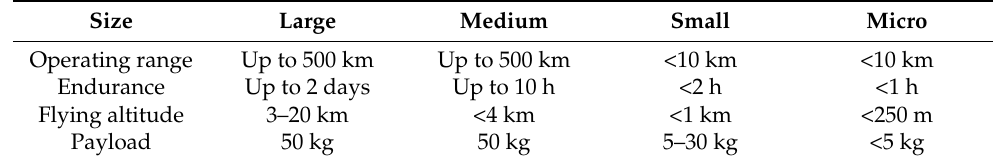
Table 3. Classes of UAS